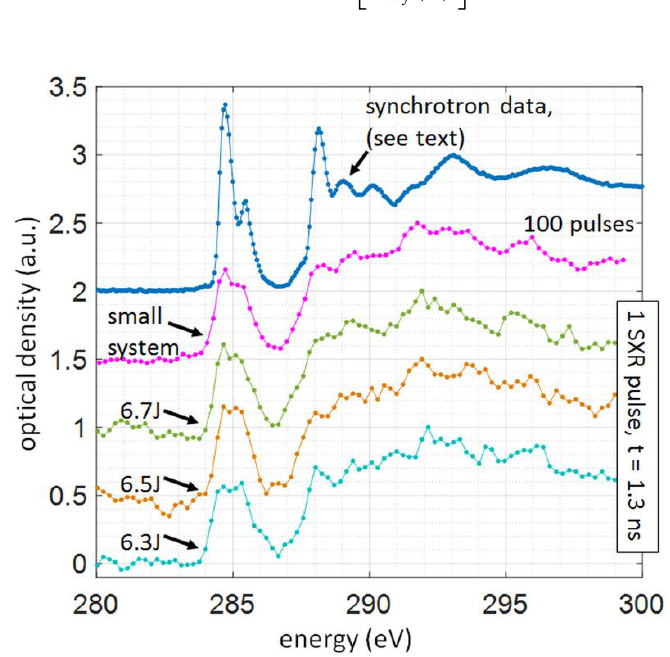
Figure 4. Polyethylene terephthalate (PET) NEXAFS spectra—optical density as a function of SXR radiation energy. The figure depicts a comparison between NEXAFS spectrum obtained using a synchrotron radiation [3], 100 SXR pulses from the compact system [22] with NEXAFS spectra of the same material and thickness, obtained with a single SXR pulse, generated by a laser interaction with a double stream gas puff target. The spectra are presented for three different laser pulse energies ranging from 6.3 J to 6.7 J and 1.3 ns laser pulse duration (FWHM).